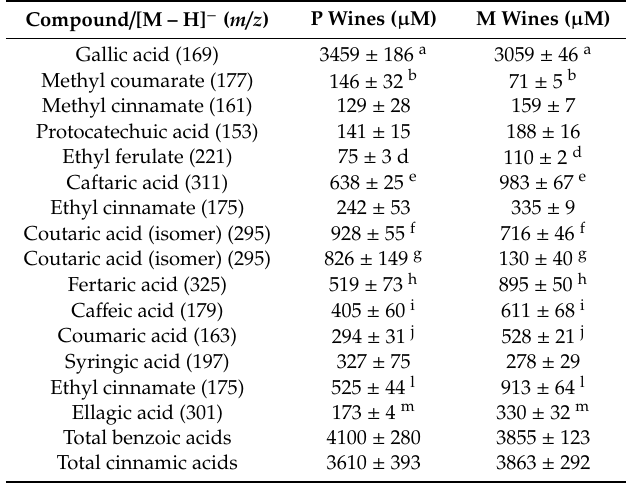
Figure 1. Graphical representation of the mean quantification ± standard deviation. ( A ) Total phenolic compounds (determined by the Folin–Ciocalteu method); ( B ) Total proanthocyanidins (determined using the Bath-Smith method); ( C ) Tannin specific activity for M and P wines samples. The presented values are the mean of three independent experiments, * Represents statistically di ff erent ( p < 0.0001). M and P refer to the wine codes. Table 2. HPLC quantification of phenolic acids and their derivatives present in P and M wines. The results are expressed as mean ± standard deviation and are the result of two extractions of each wine bottle and triplicate injections. Values with the same letter di ff er statistically when p < 0.05. The m / z are in the negative ion mode.